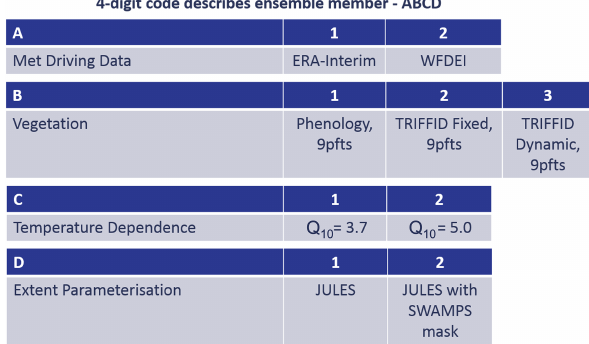
Figure 1. Description of the 24 JULES ensemble members used in this study, comprising 2 meteorological driving data configurations, 3 vegetation configurations, 2 temperature dependencies and 2 wet- land extent configurations. The four-digit code (ABCD) is used to identify the individual ensemble